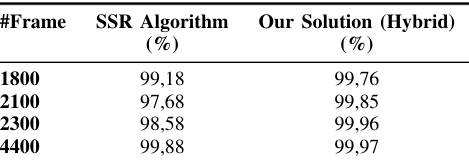
Fig. 11. Default behavior of the acceleration structures, verified in our performance testings using the NVIDIA OptiX . TABLE I I MAGE QUALITY RESULTS OF FOUR DIFFERENT FRAMES FROM THE WALKTHROUGH SEQUENCE , IN TERMS OF REFLECTIONS , COMPARED TO THE IDEAL CORRESPONDING IMAGES GENERATED BY THE RAY TRACING WITH STATIC OBJECTS .